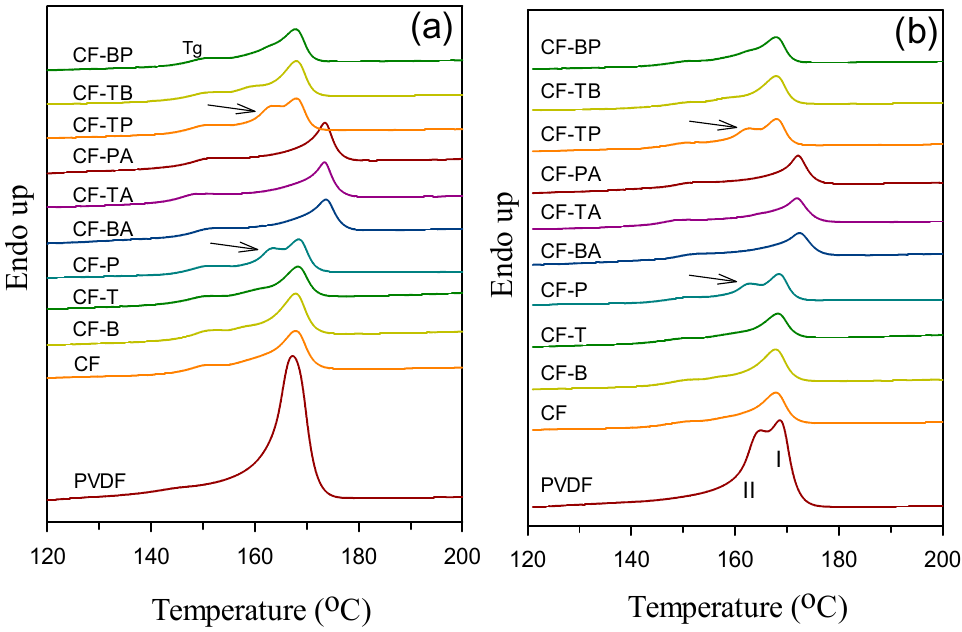
Figure 5. DSC heating curves of ( a ) 5 °C/min and ( b ) 40 °C/min precooled